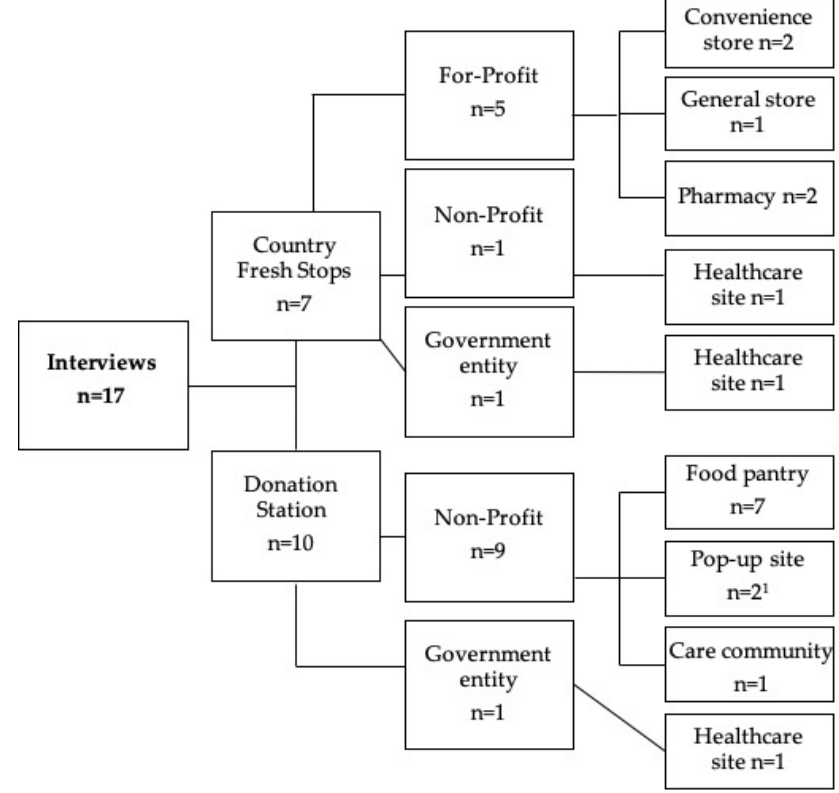
Figure 3. Site affiliate categorizations. 1. Pop-up sites included a school and a library.